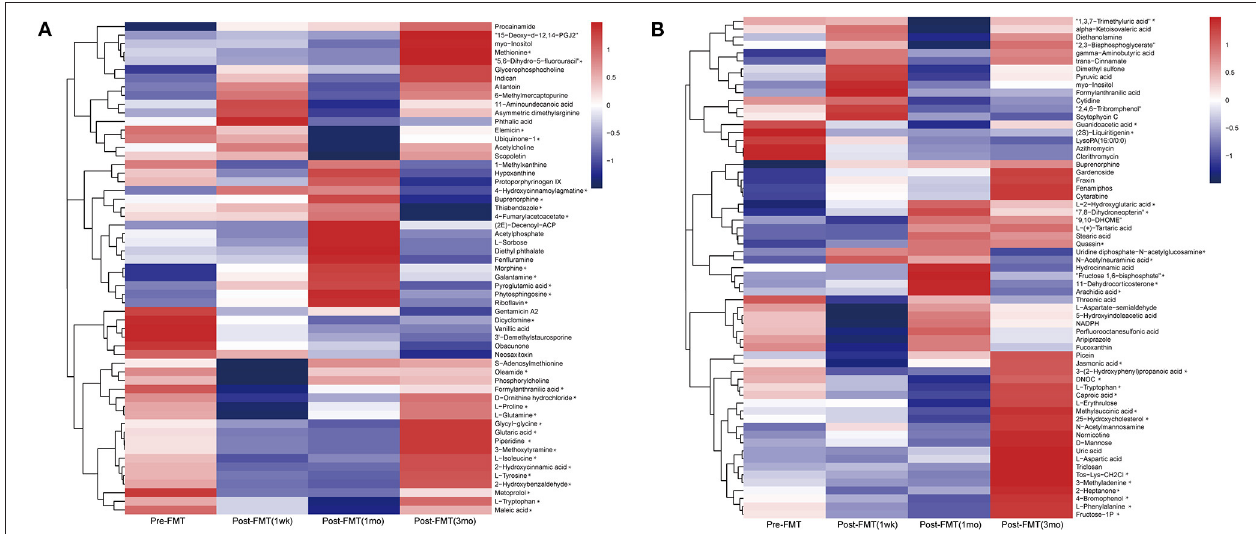
FIGURE 2 | Metabolite profiles before and after fecal microbiota transplantation. The untargeted metabolomics analysis of the serum was conducted under positive (A) and negative (B) ion state, respectively. *The change trend is the same as the clinical symptoms.